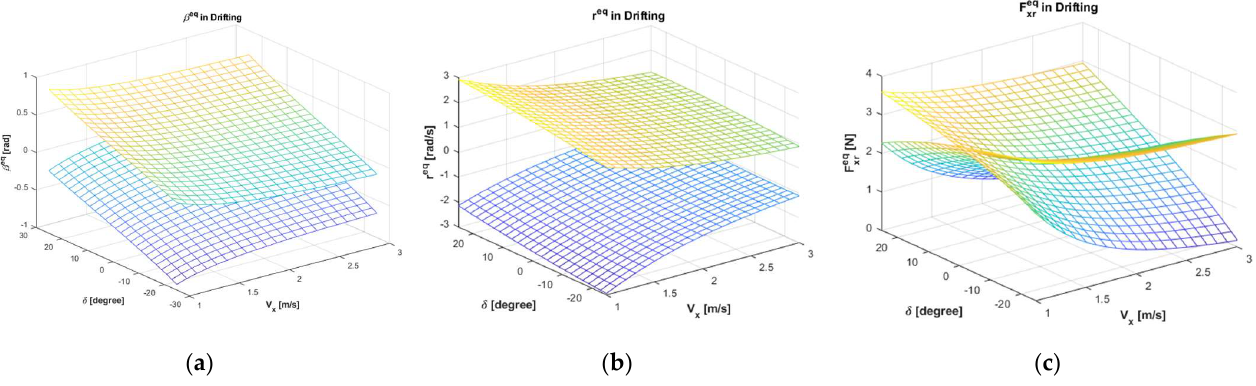
Figure 7. 3D maps of the equilibrium states of the ( a ) sideslip angle ( 𝛽 ), ( b ) yaw rate ( 𝑟 ), and ( c ) rear-wheel force ( 𝐹 𝑥𝑟 ).